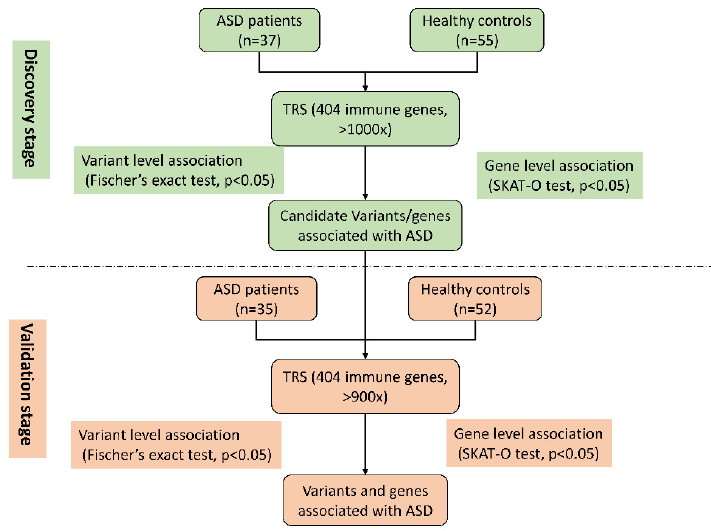
Figure 1. Flowchart of study design.